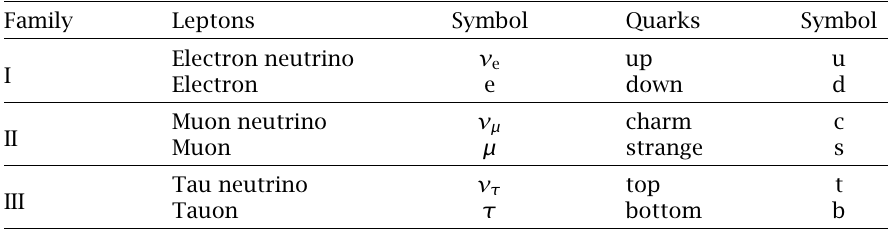
Table 2 . Particles of matter fields